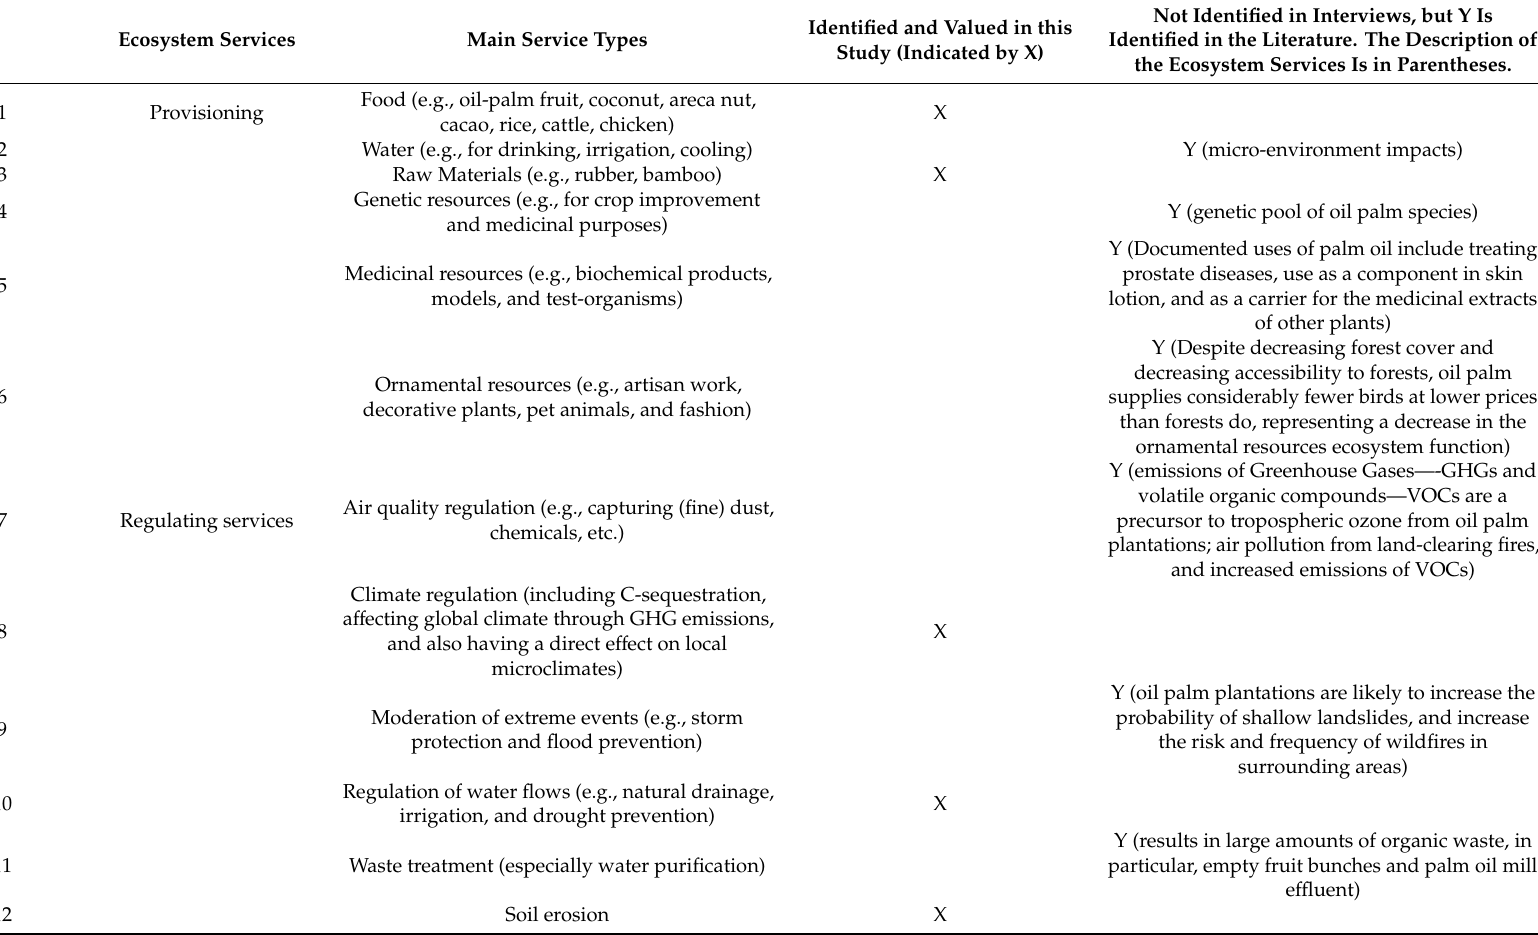
Table 2. Ecosystem services that are identified and valued in the study using the Economics of Ecosystems and Biodiversity (TEEB) typology (adapted from [14,17]). Ecosystem Services Main Service Types